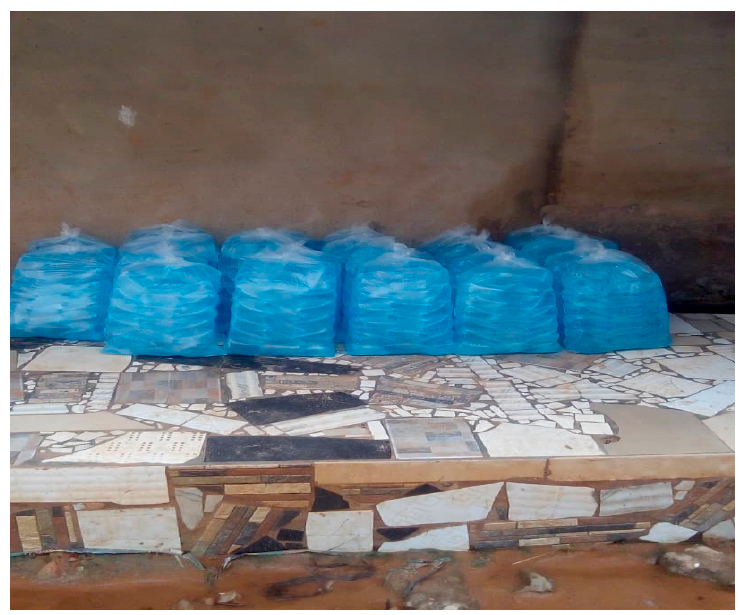
Figure 3. Packaged pure water from the factory.